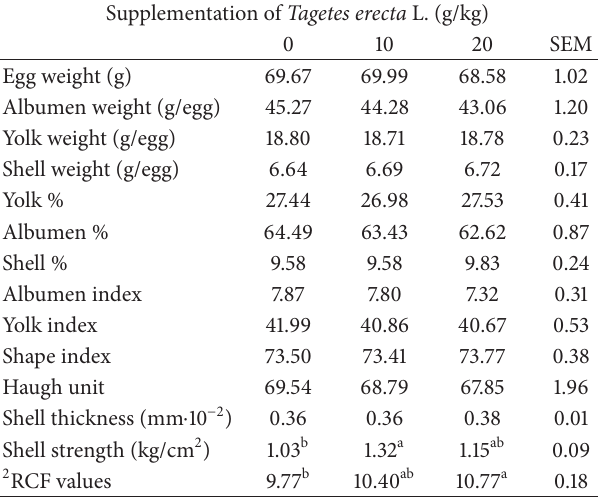
Table 3: The effects of diets supplemented with different levels of Tagetes erecta L. on the egg parameters 1 .